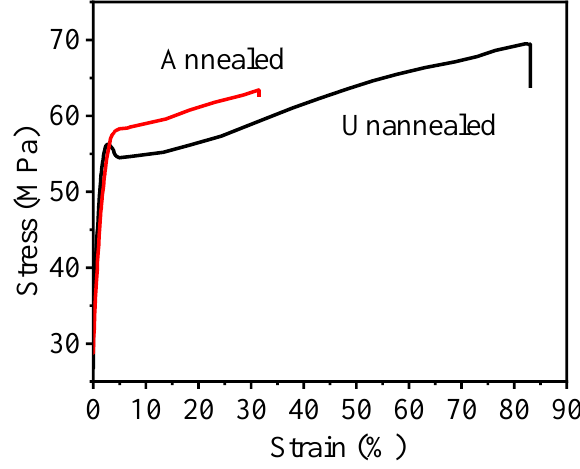
Figure 10. Engineering stress‒strain curves of unannealed and annealed films.